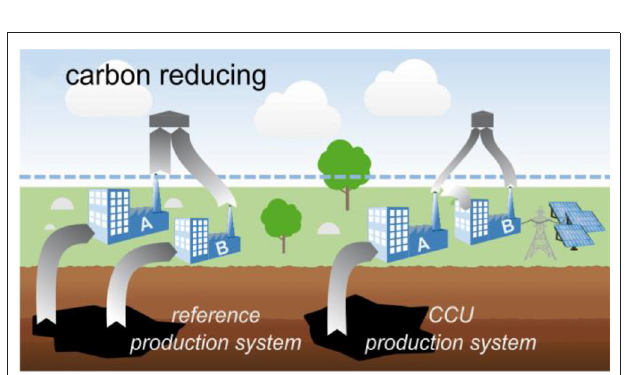
FIGURE 12 | Carbon reducing: CCU technologies can offer lower CO 2 emissions than the status quo and thus, may be considered as carbon-reducing